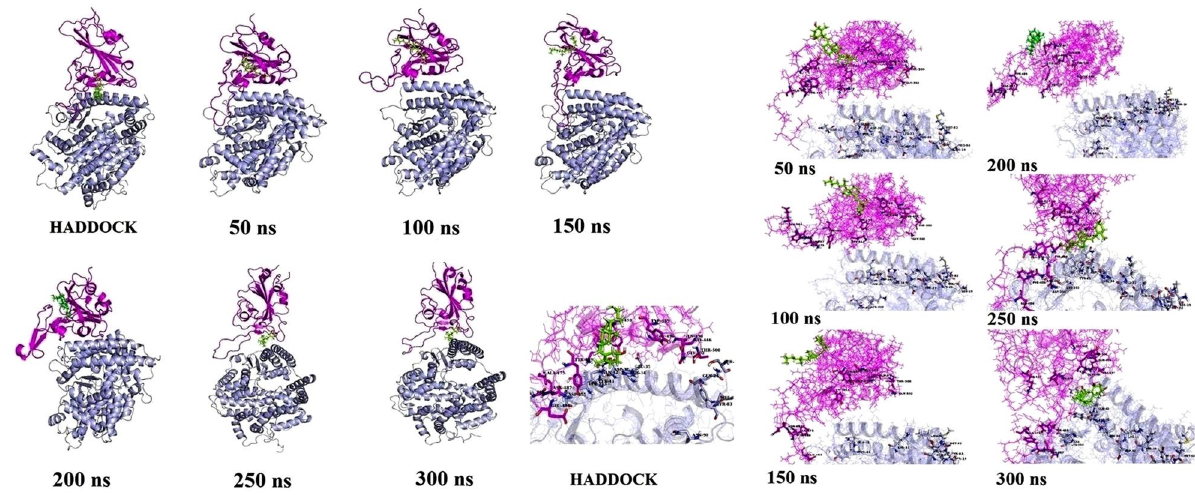
Figure 8. The snapshot was taken from the MD trajectory of the Spike-Calcitriol/ACE2 system at 0, 50, 100, 150, 200, 250, and 300 ns. ACE2, spike, and calcitriol colored by blue, purple and green,